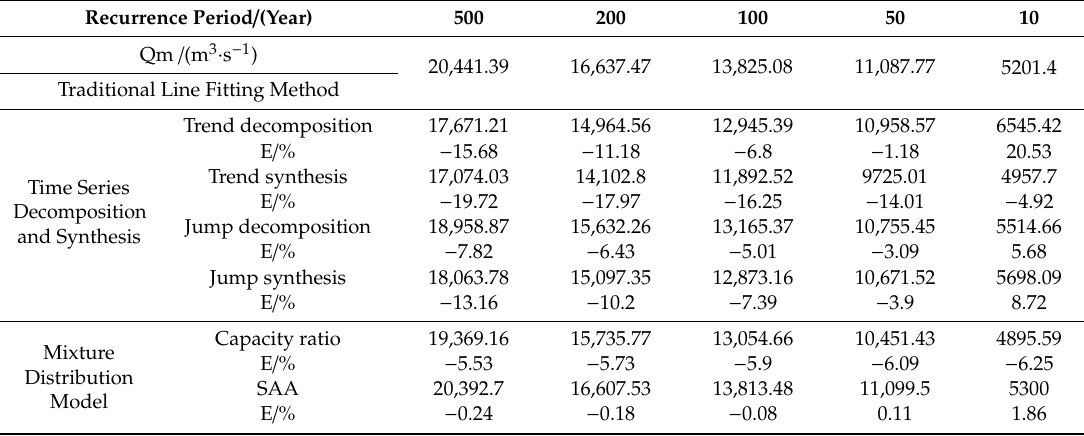
Table 5. Design value comparison between traditional method and other